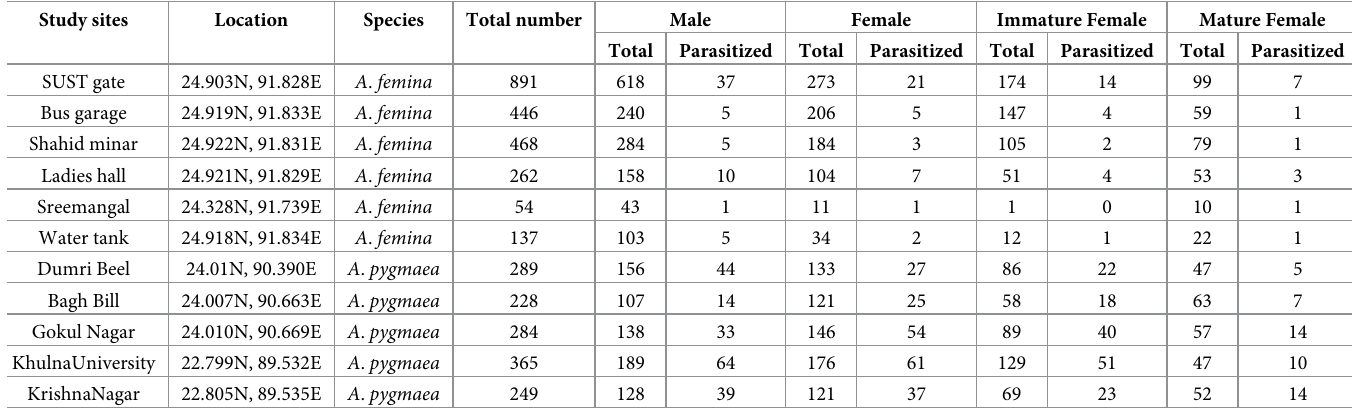
Table 1. Study sites, locations and number of total and parasitized Agriocnemis femina and Agriocnemis pygmaea captured to calculate parasite prevalence. Study sites